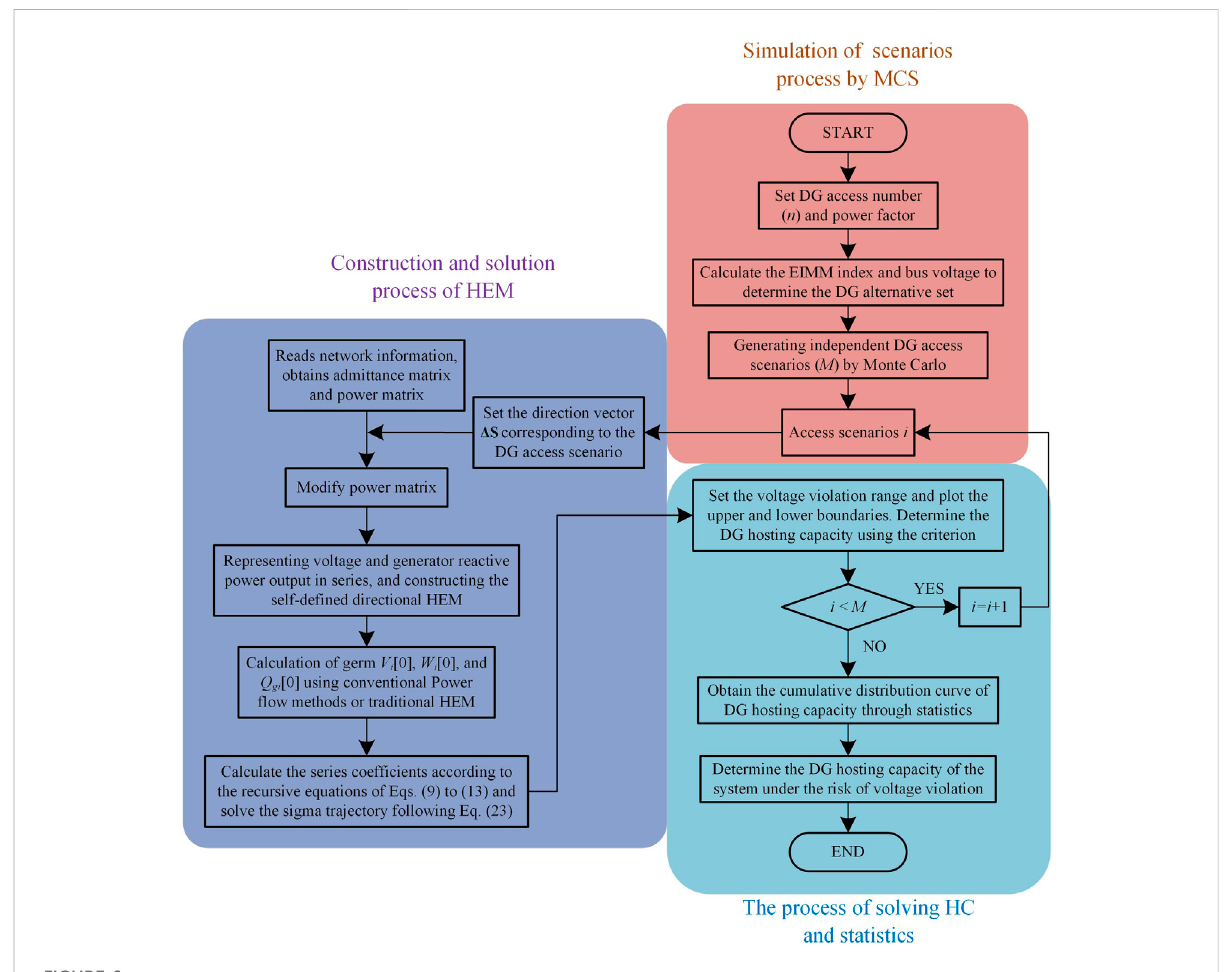
FIGURE 6 Flow chart of DG hosting capacity assessment of distribution